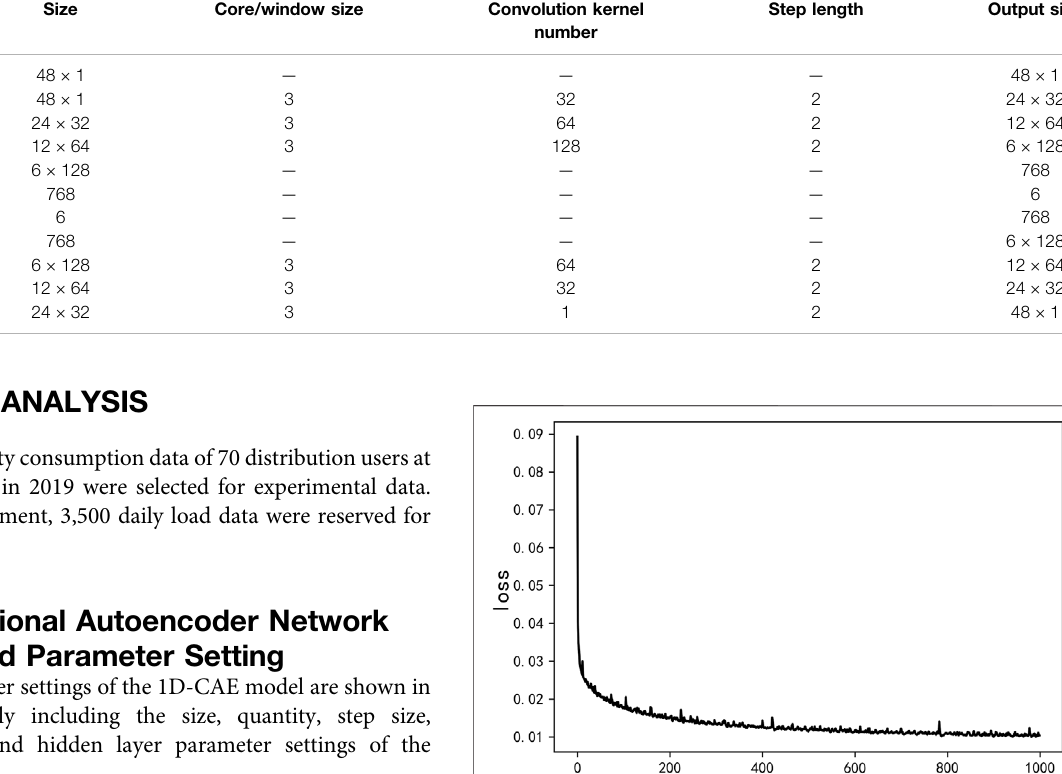
TABLE 1 | Network structure of 1D-CAE. Type